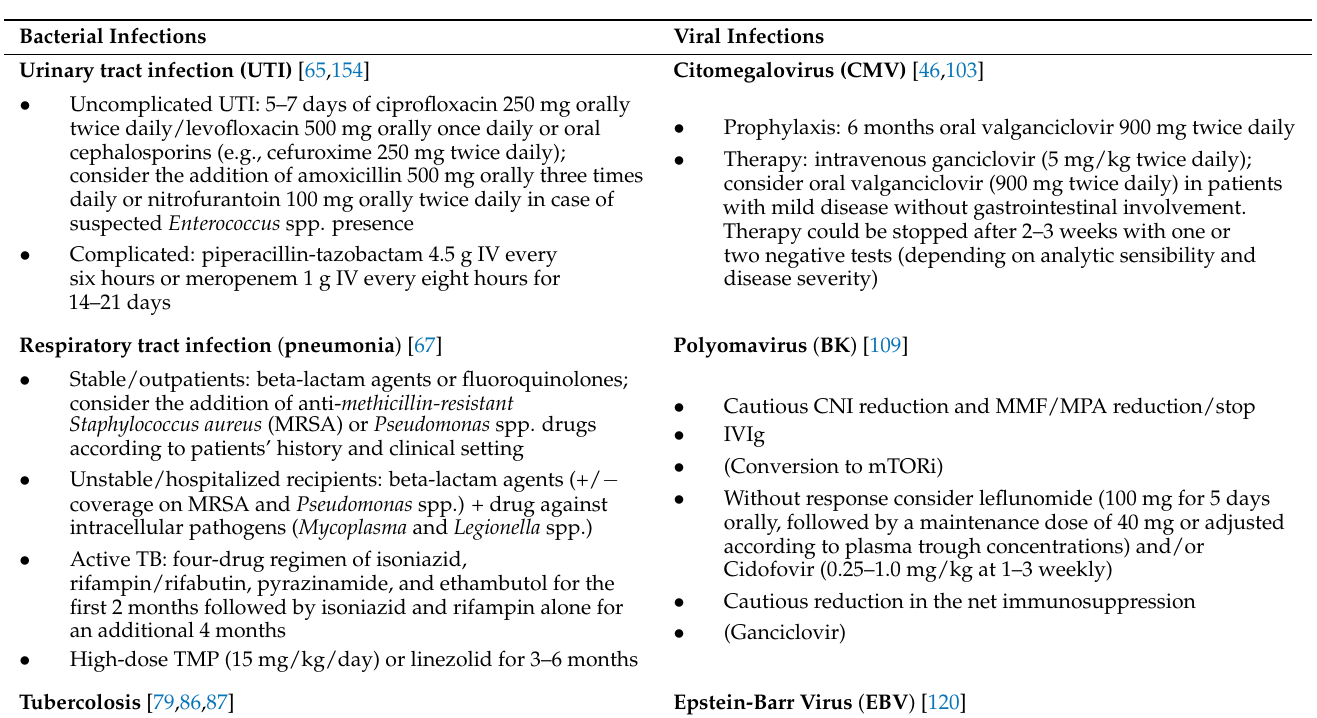
Table 2. Most adopted approaches in common bacterial and viral infections according to recent literature